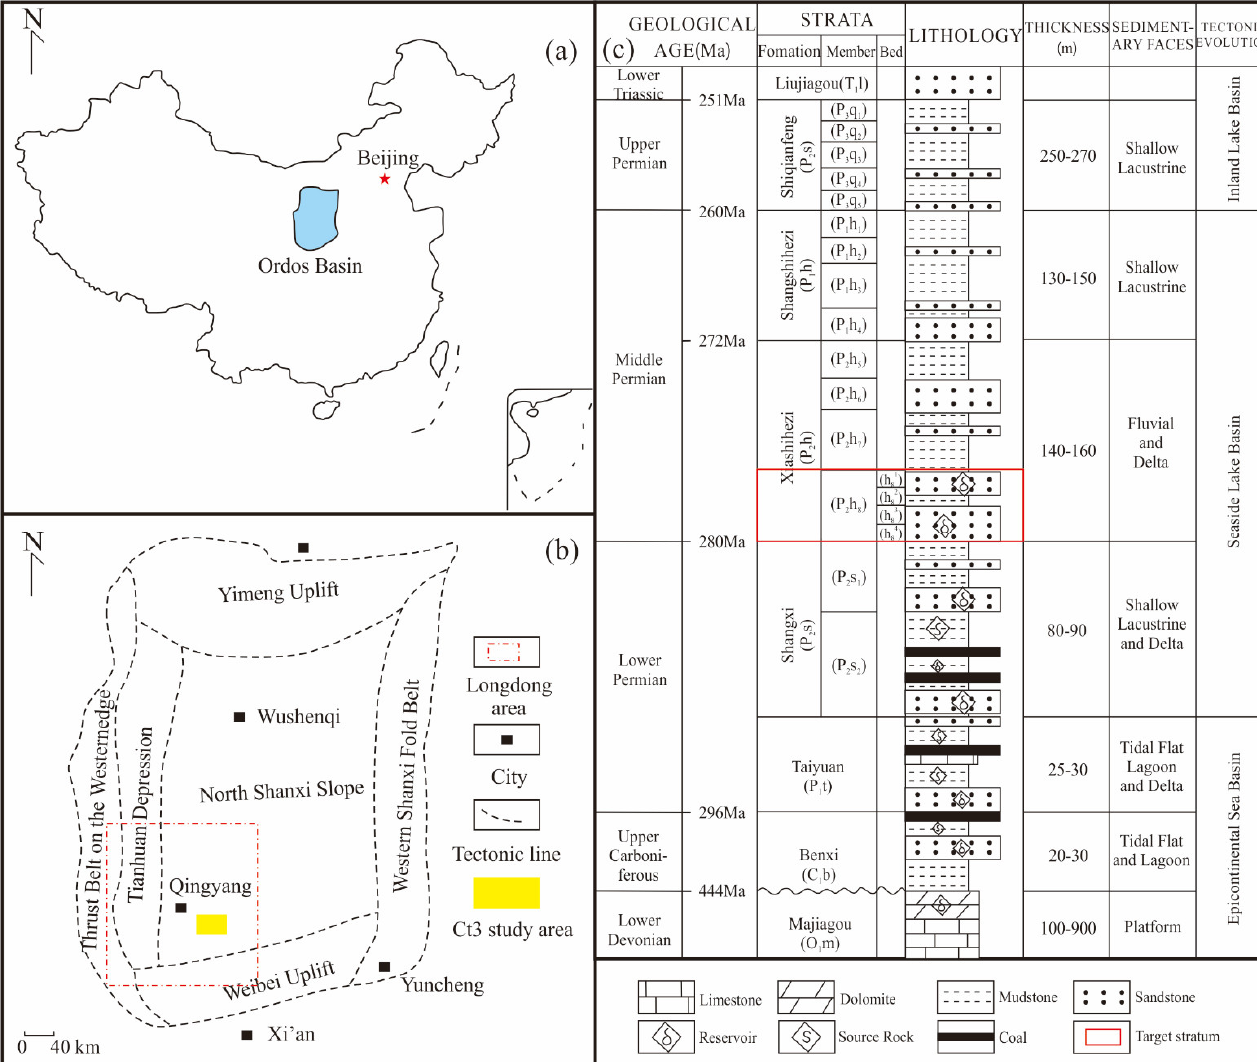
Figure 1. ( a ) Ordos Basin in China; ( b ) Ordos basin tectonic units and Longdong area; ( c ) sequence stratigraphic framework and sedimentary environment in Longdong area.